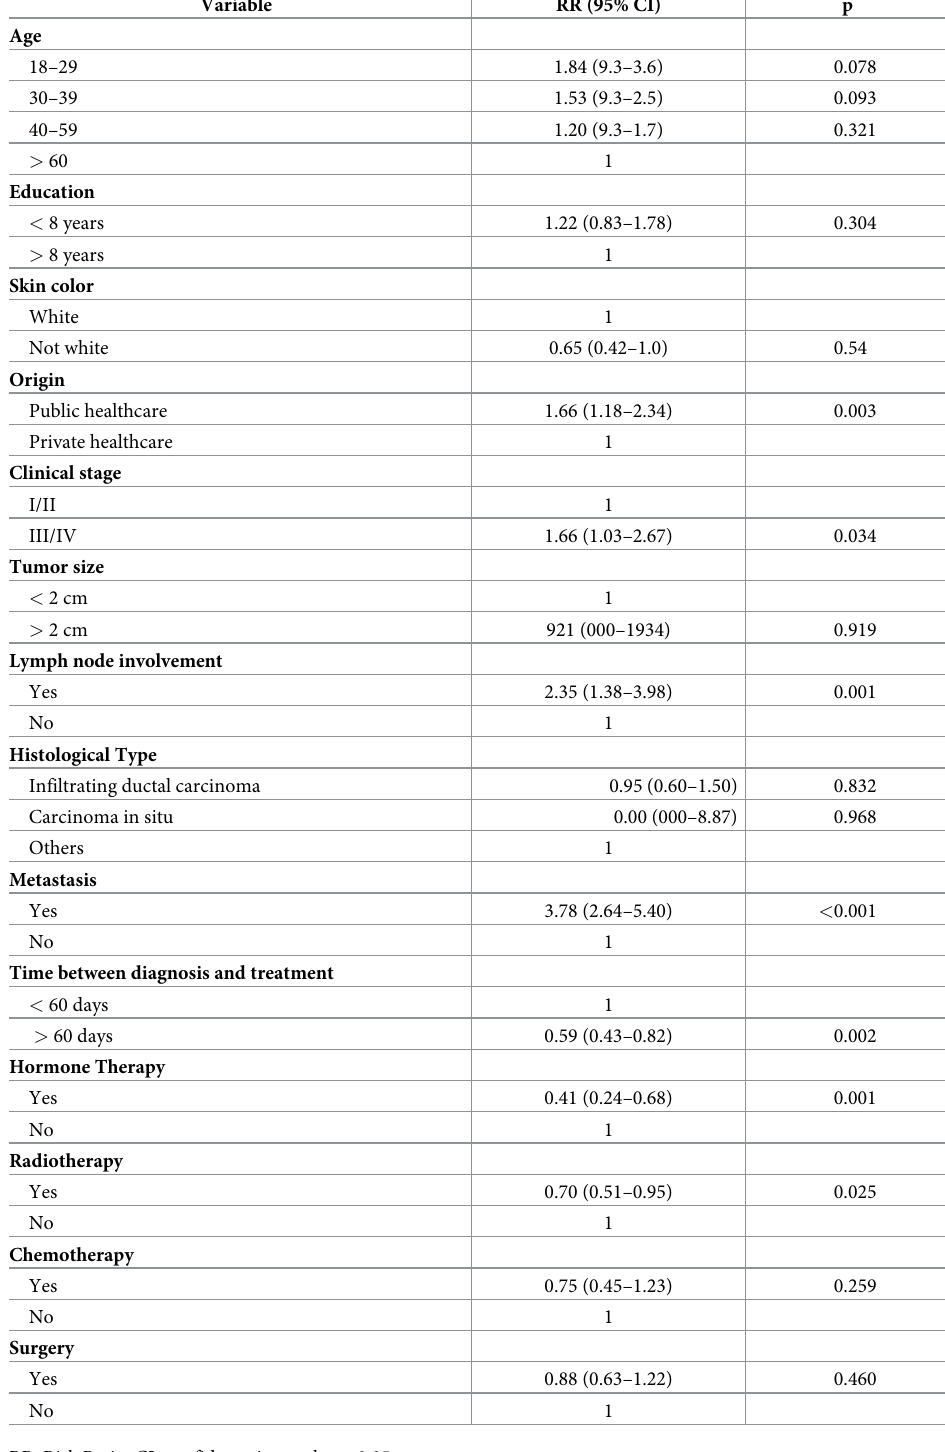
Table 3. Multivariate analysis of five-year overall survival of women with breast cancer. Bele´m, Para´, Brazil, 2007–